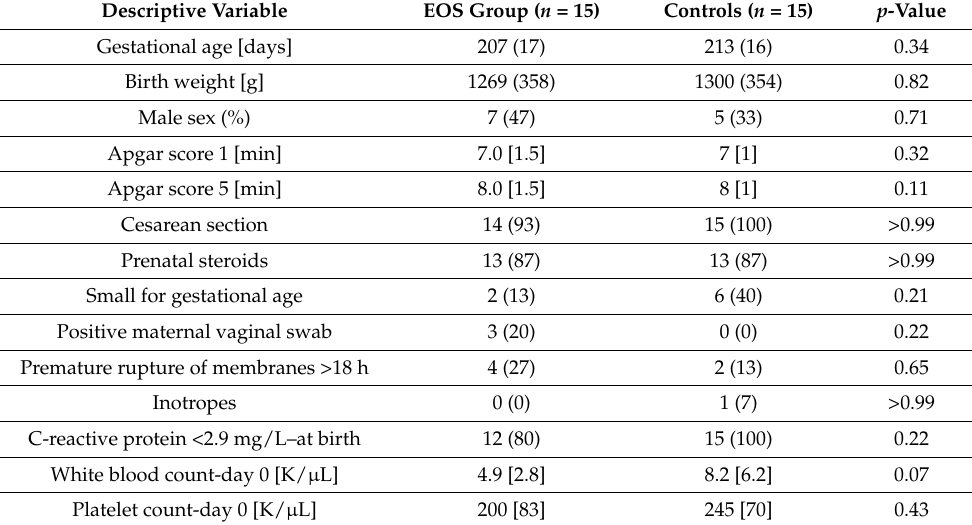
Table 1. The recruited neonates’ demographic and perinatal characteristics, and laboratory findings at birth; numerical data normally distributed are reported as mean (standard deviation), whereas non-normally distributed data as median[interquartile range], and categorical data as the number of cases (percentage) with respect to the reference